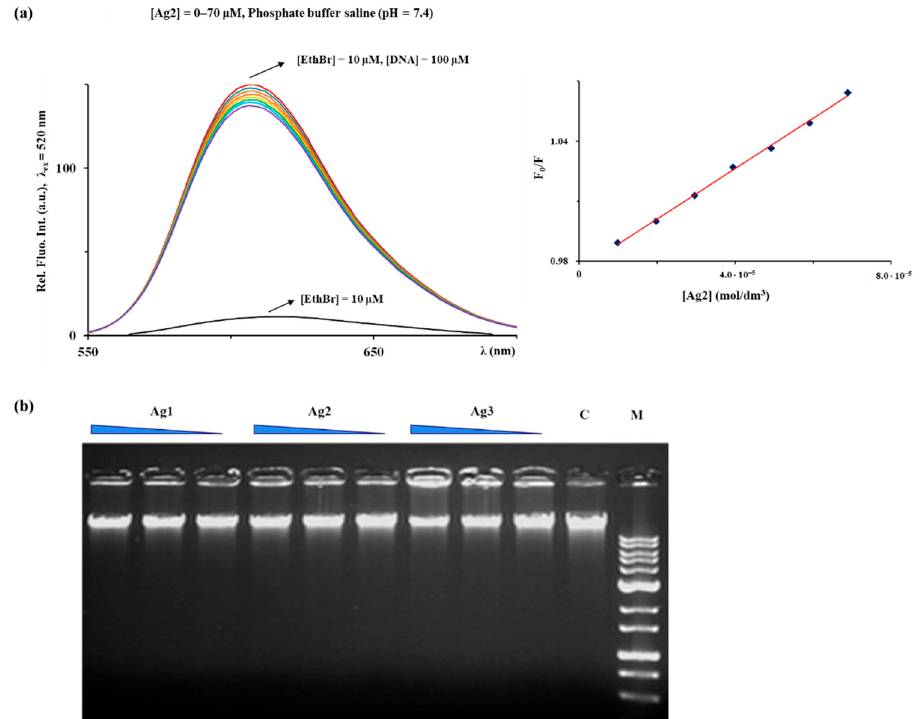
Figure 7. ( a ) Fluorescence emission spectra of EthBr–DNA system in the presence of an increasing amount of Ag2 complex. The arrow shows the intensity changes upon the gradual addition of the complex. Inserted graph: Stern-Volmer plots of F 0 /F vs. complex. ( b ) Interaction of silver(I) complexes Ag1 – 3 with commercial lambda bacteriophage DNA assessed by gel electrophoresis. 0.8% agarose gel with EthBr against a HyperLadder™ 1 kb DNA Ladder plus (FastGene) (Mw), DMSO is a control sample (C). Gel visualization by the Gel Doc EZ system (Bio-Rad, Life Sciences, Hercules, USA), equipped with the Image Lab™